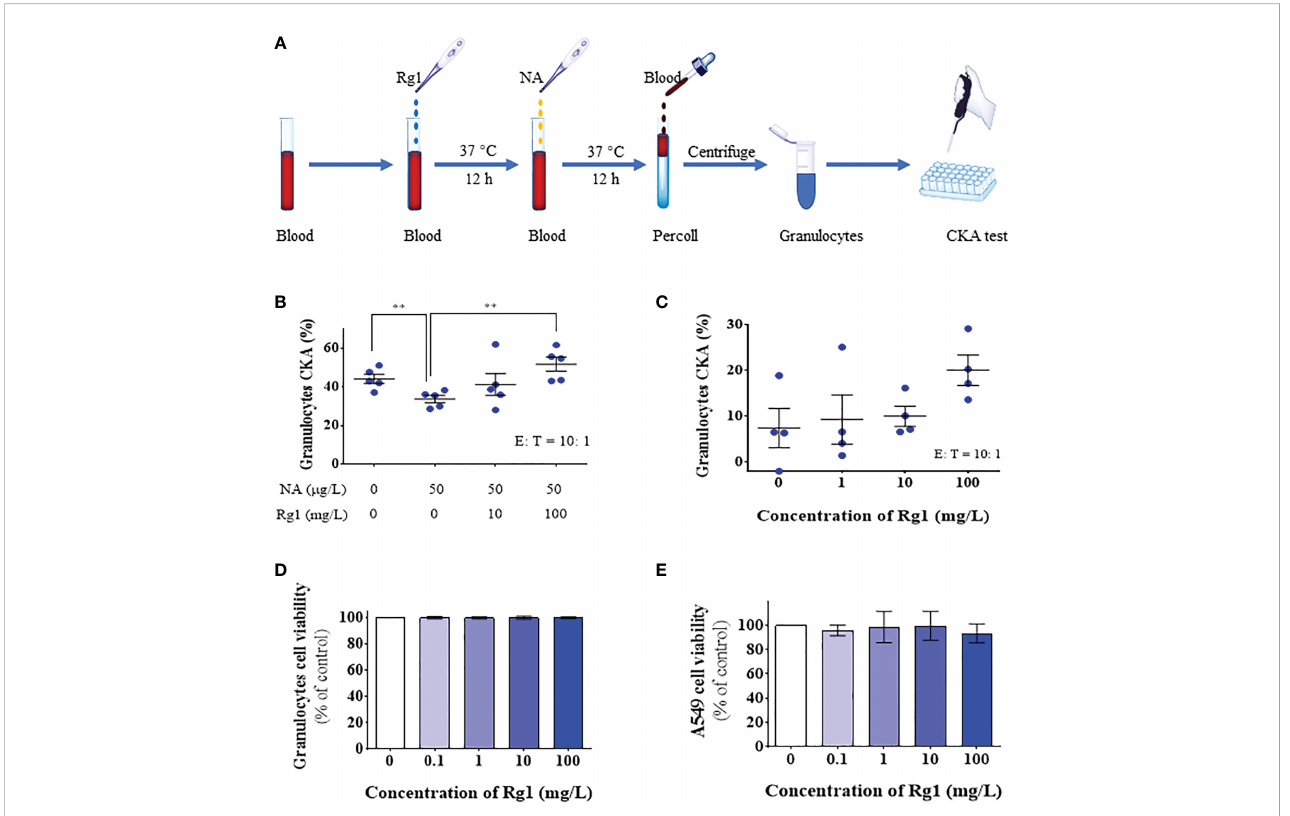
FIGURE 2 In vitro , ginsenoside Rg1 could enhance the anti-cancer function of granulocytes inhibited by noradrenaline (NA). (A) Detection of the effects of ginsenoside Rg1 on the anti-cancer function of granulocytes inhibited by NA. (B) The effects of ginsenoside Rg1 on granulocyte cancer-killing activity (CKA) immunosuppressed by NA at different concentrations (n = 5; mean ± SD; two-tailed student ’ s t-test; **, P < 0.01). (C) The effects of ginsenoside Rg1 on granulocyte CKA at different concentrations. (D) The effects of ginsenoside Rg1 on granulocyte cell viability at different concentrations. (E) The effects of ginsenoside Rg1 on A549 cell viability at different